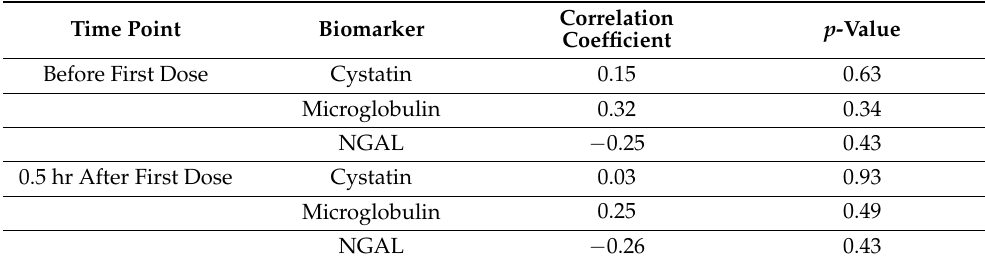
Table 4. Spearman correlations of serum biomarkers with serum creatinine.